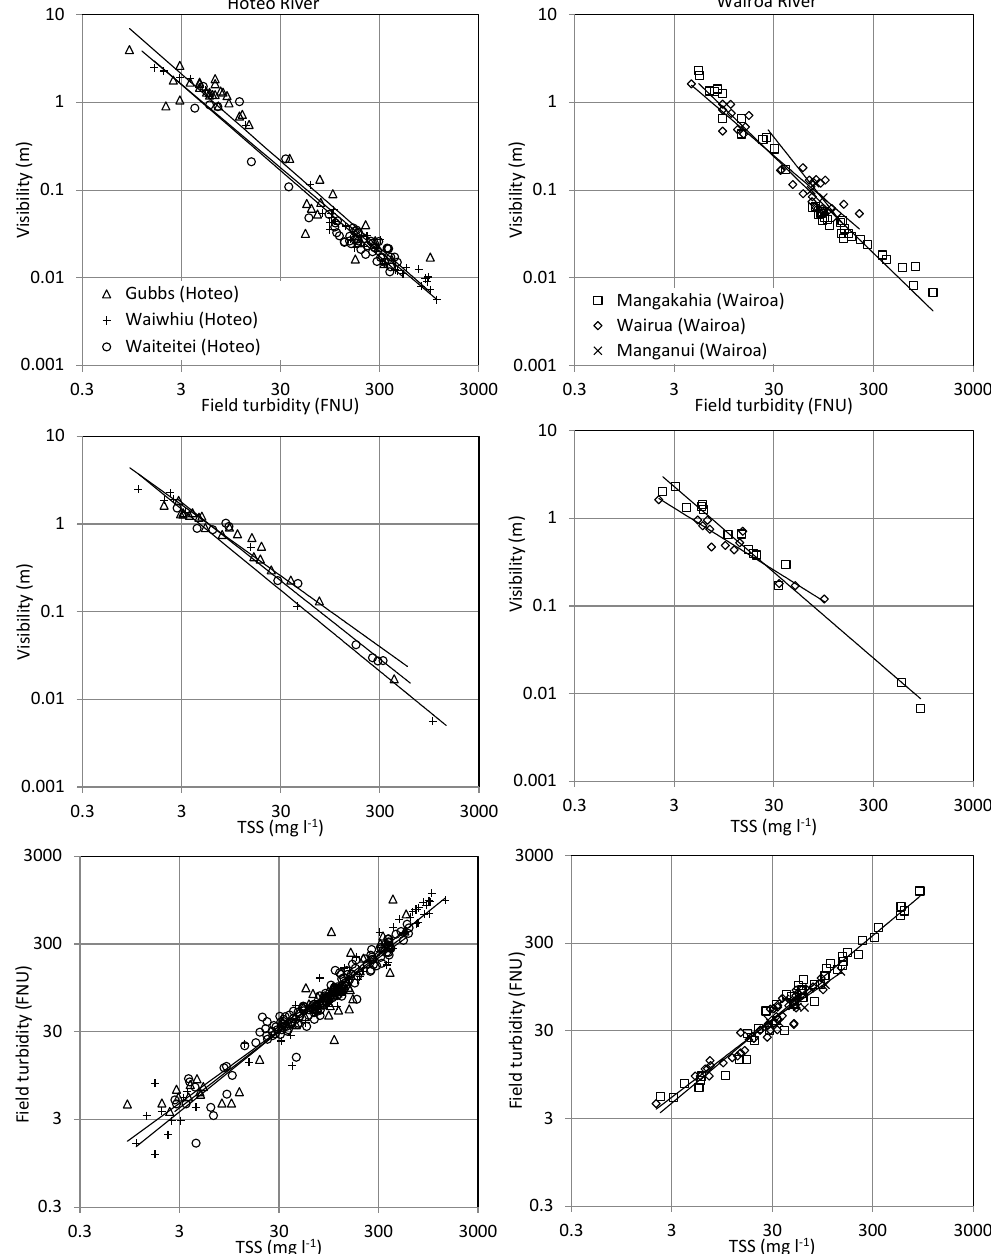
Fig. 2 Mutual relationships of visual clarity, turbidity and TSS for the six (3 Hoteo, 3 Wairoa) monitoring sites. Regression lines were fitted by power law (regression summaries are presented in Table 1).